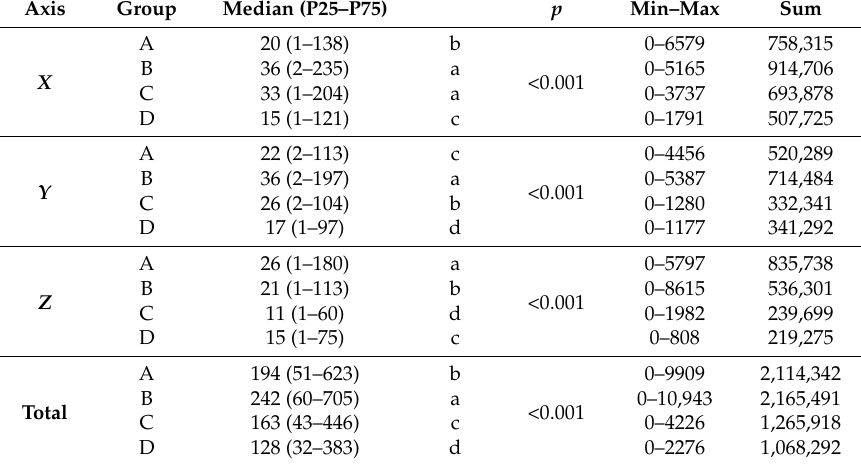
Table 2. Model 1 (without angulation). Comparison of the values of the square of the X-deviation, Y-deviation, Z-deviation, and the total in the impressions of groups A (closed tray impressions with replacement abutments), B (open tray impressions for dragging copings, without splitting), C (open tray impressions for ferrules), and D (using the 3M™ True Definition Scanner).